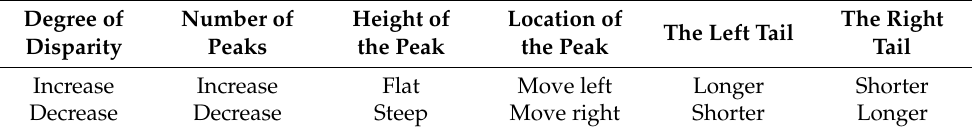
Table 5. Relationship between the kernel density function distribution and the degree of disparity. Degree of Number of Height of Location of The Right The Left Tail Disparity Peaks the Peak the Peak Tail Increase Flat Move